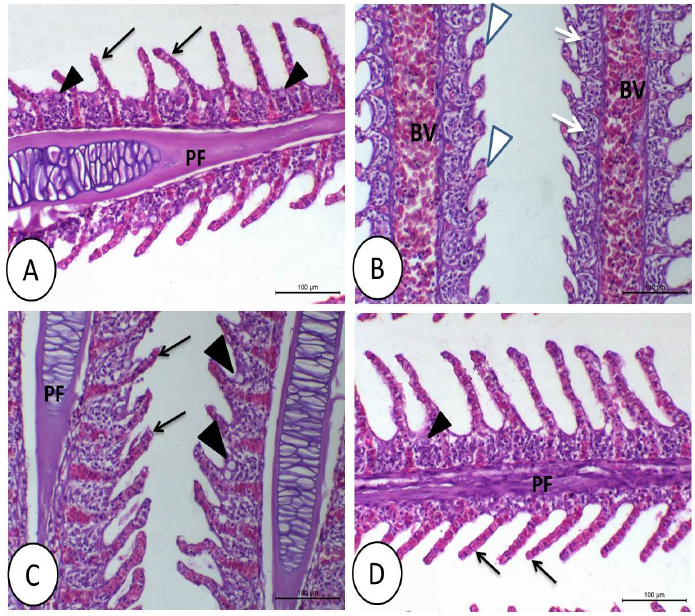
Figure 2. Histology of gills of Nile tilapia in the control ( A ), deltamethrin (DMT) ( B ), synbiotic ( C ), and DMT with synbiotic ( D ) groups. In ( A , C , D ), the gills show normal histological structures, including primary filaments (PF), secondary filaments (black arrow), and mucous cells (black arrow- head) between the secondary filaments. The toxic effect of DMT ( B ) causes telangiectasia and erosion of secondary filaments (white arrowhead), congestion of blood vessels of primary filaments (BV), and degeneration of epithelial lining (white arrow). H&E staining; bar = 100 μ m.